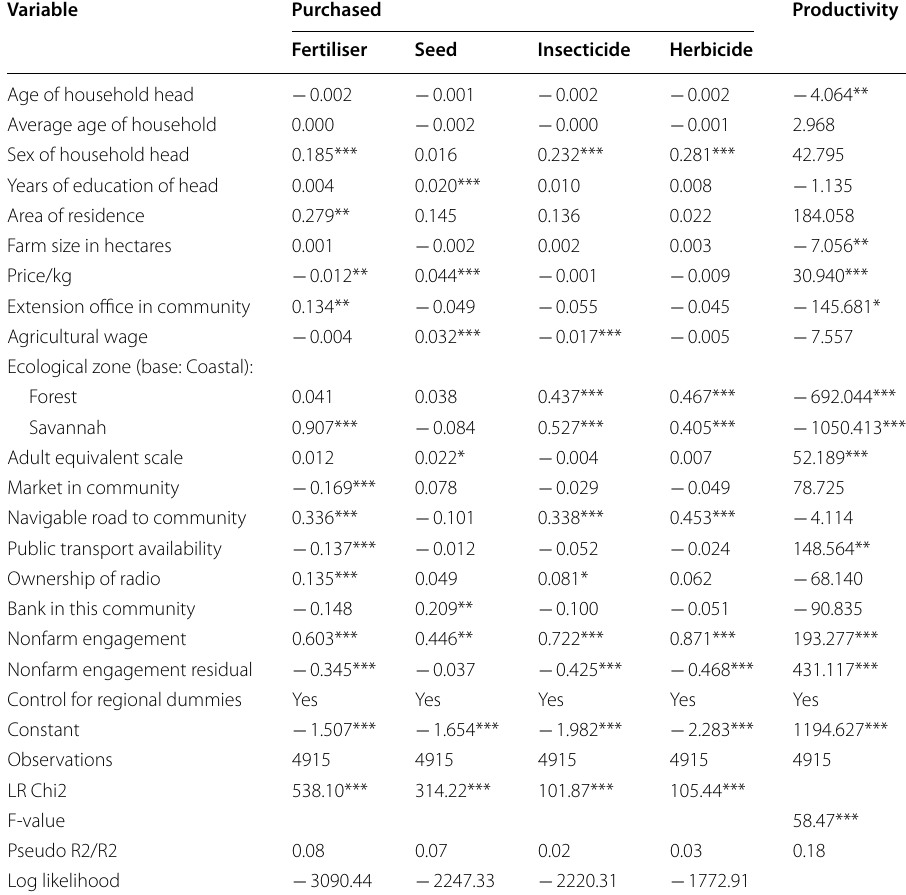
Table 7 Effect of NFE on purchased inputs and productivity